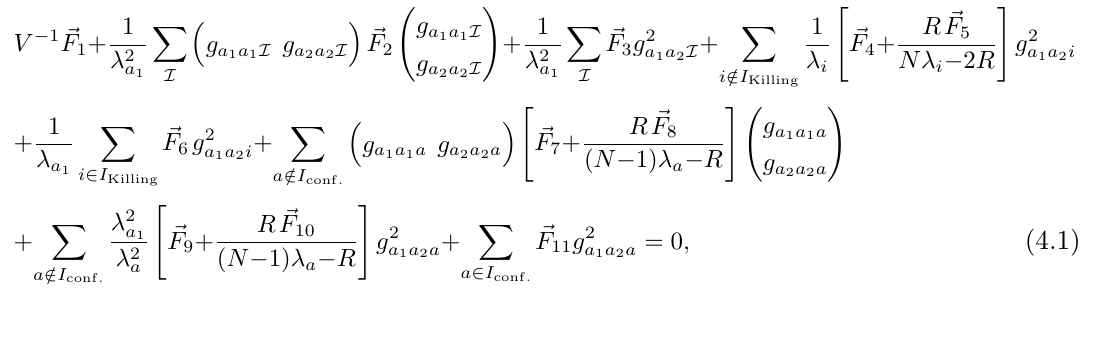
Figure 14 . Upper bounds on j g a with R (cid:21) 0 and N = 2 ; 4 ; : : : ; 16, assuming that (cid:21) a (cid:21) (cid:21) a